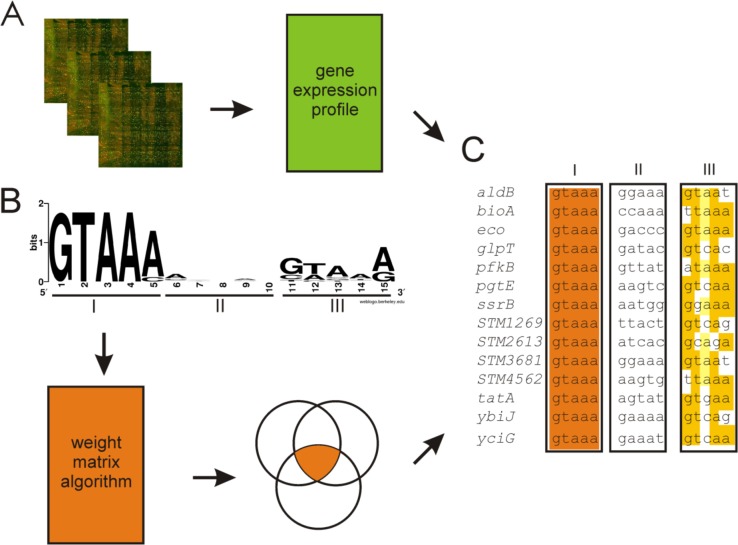
Genome wide identification of novel CpxR dependent genes in S. Typhimurium.A. Global transcriptional analysis was performed by comparing the gene expression profile of a cpxA mutant (SHS01) to a wild-type strain (SL1344) grown under invasion inducing conditions. Genes for which the ratio of the cpxA-null strain to the wild-type strain is e4 fold with a P value of <0.005 were clustered using Tibco Spotfire DecisionSite default. B. Bioinformatics-based screening for direct CpxR targets. The sequence logo for the CpxR~P recognition weight matrix in S. Typhimurium is given with the left (I) and right pentamers [28] and the 5-bp spacer marked by roman numerals. The base conservation measured in bits is shown as the relative height of each base [54]. C. Potential novel Cpx regulon members of S. Typhimurium identified by global transcriptional analysis and bioinformatic screening. The left (I) and right [28] pentamers and the 5-bp spacer [28] are displayed as a heat-map to show bases of high conservation (orange) from degenerate regions (light grey/white). The genes controlled by these promoters are indicated to the left of the sequences.